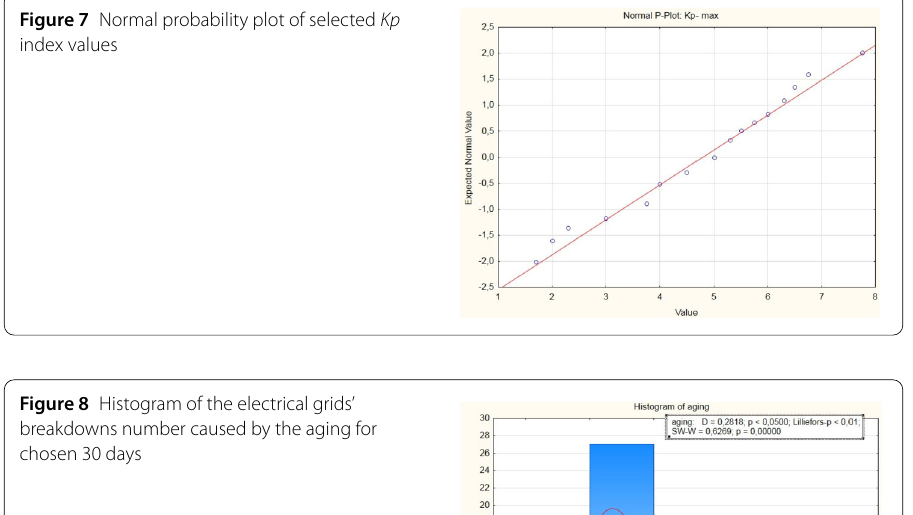
Figure 8 Histogram of the electrical grids’ breakdowns number caused by the aging for chosen 30 days